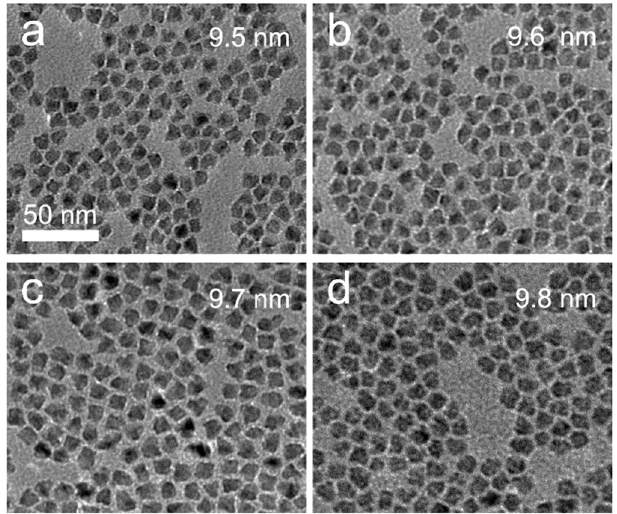
Figure 2. Transmission electron microscope images of the ( a ) R − CdS, ( b ) T − ZnSe, ( c ) t − ZnSe and ( d ) R − ZnCdS quantum dots.